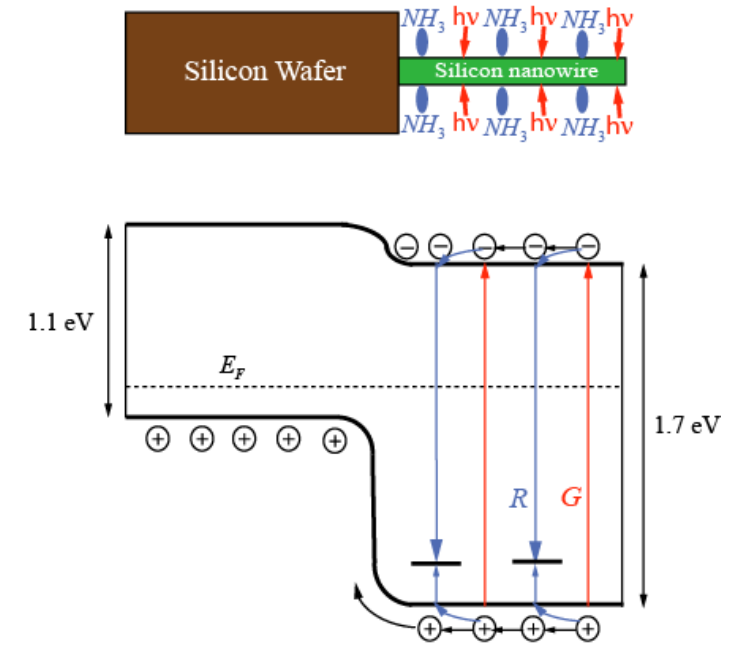
Figure 4. Simplified model of heterojunction energy diagram between silicon nanowire and crystalline silicon wafer under light illumination at wavelength 730 nm and ammonia molecule